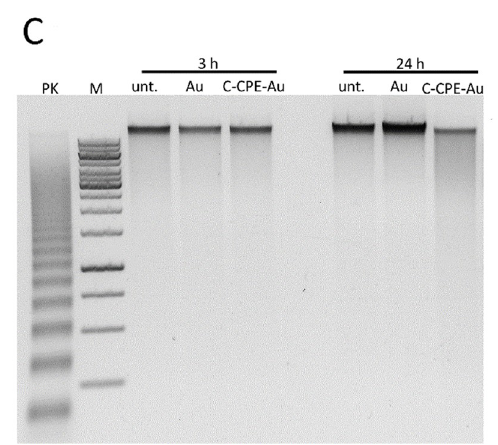
Figure 4. The caspase inhibition did not antagonize the cell death induced by GNOME-LP applied in presence of C-CPE-AuNPs. ( A ) Application of GNOME-LP (5 mm/s; 30 mJ/cm 2 ) in the presence or absence of C-CPE-AuNPs did not increase the activity of caspase-3/-7. The presence of the caspase inhibitor Z-VAD-FMK (20 µM) was able to reduce the activity of caspase-3/-7. The graphs represent the mean ± SEM of caspase-3/-7 activity relative to untreated cells without Z-VAD-FMK as control reference. The results were analyzed with Student’s t test. * Significant difference to the control reference: ** p < 0.01, *** p < 0.001. # Significant difference to the control reference with Z-VAD-FMK: ### p < 0.001. ( B ) Applied in presence of C-CPE-AuNPs, GNOME-LP reduced the cell survival 0.5 h, 3 h, or 24 h after GNOME-LP application. The presence of Z-VAD-FMK (20 µM) was not able to protect the cells. The graphs represent the mean ± SEM of cell survival relative to untreated cells. The data were compared by Student’s t test. * Significant difference to the control reference: *** p < 0.001. # Significant difference to untreated cells with Z-VAD-FMK: ### p < 0.001. ( C ) Analysis of the DNA by gel electrophoresis showing that application of GNOME-LP in the presence of C-CPE-AuNPs did not induce DNA laddering; 100 ng DNA of each probe was applied to 1% agarose gel. Positive control (PK) DNA of U937 cells treated with 4 µg/mL camptothecin for 3 h (provided by the DNA ladder kit), 1 kbp marker (M), and DNA isolated from Caco-2 cells after 3 h and 24 h of laser irradiation.